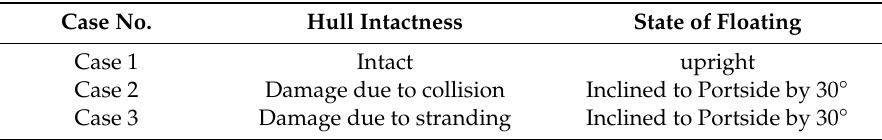
Table 4. Cases for validating the PSO-based Smith Method.